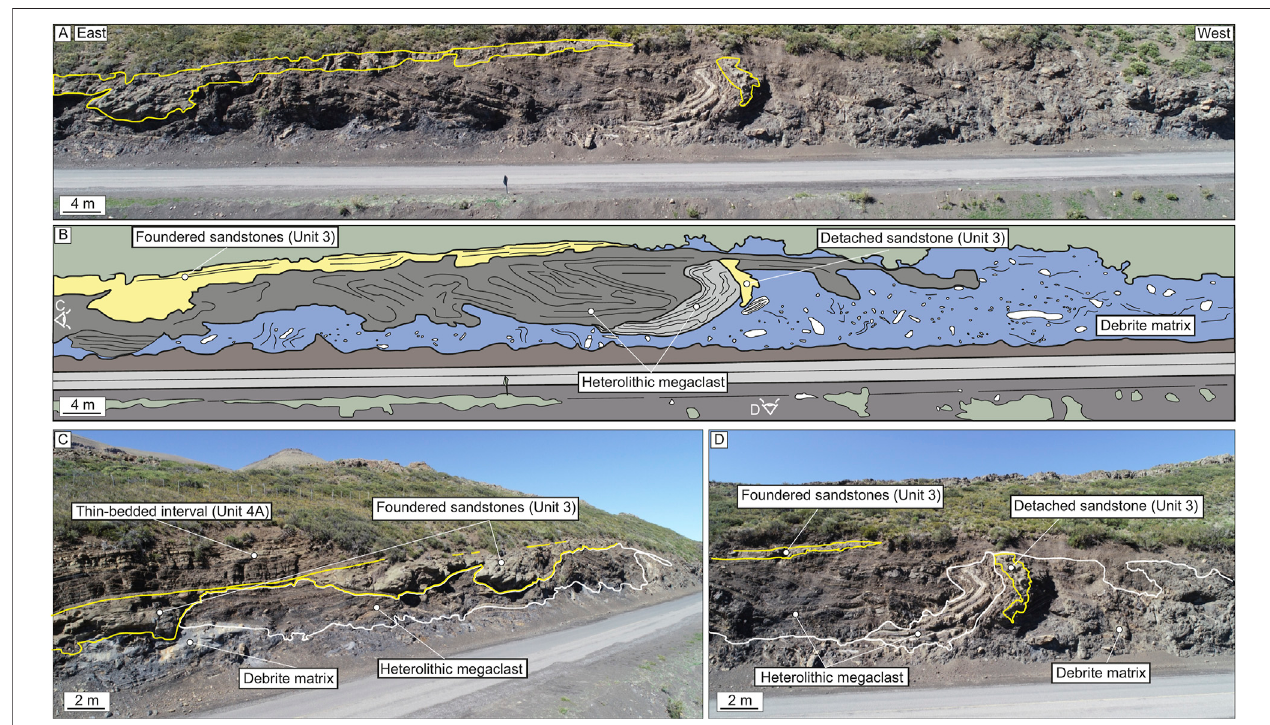
FIGURE 5 | (A) Panorama of the exposure showing the upper division of Unit 2 overlaid by Unit 3 foundered sandstone. (B) Sketched exposure of A. Note the matrix-supported texture and the chaotic distribution of clasts. (C) and (D) Same exposure of A from a different perspective. Note the unconformable base and conformable fl at top interface of Unit 3 sandstones. See B for